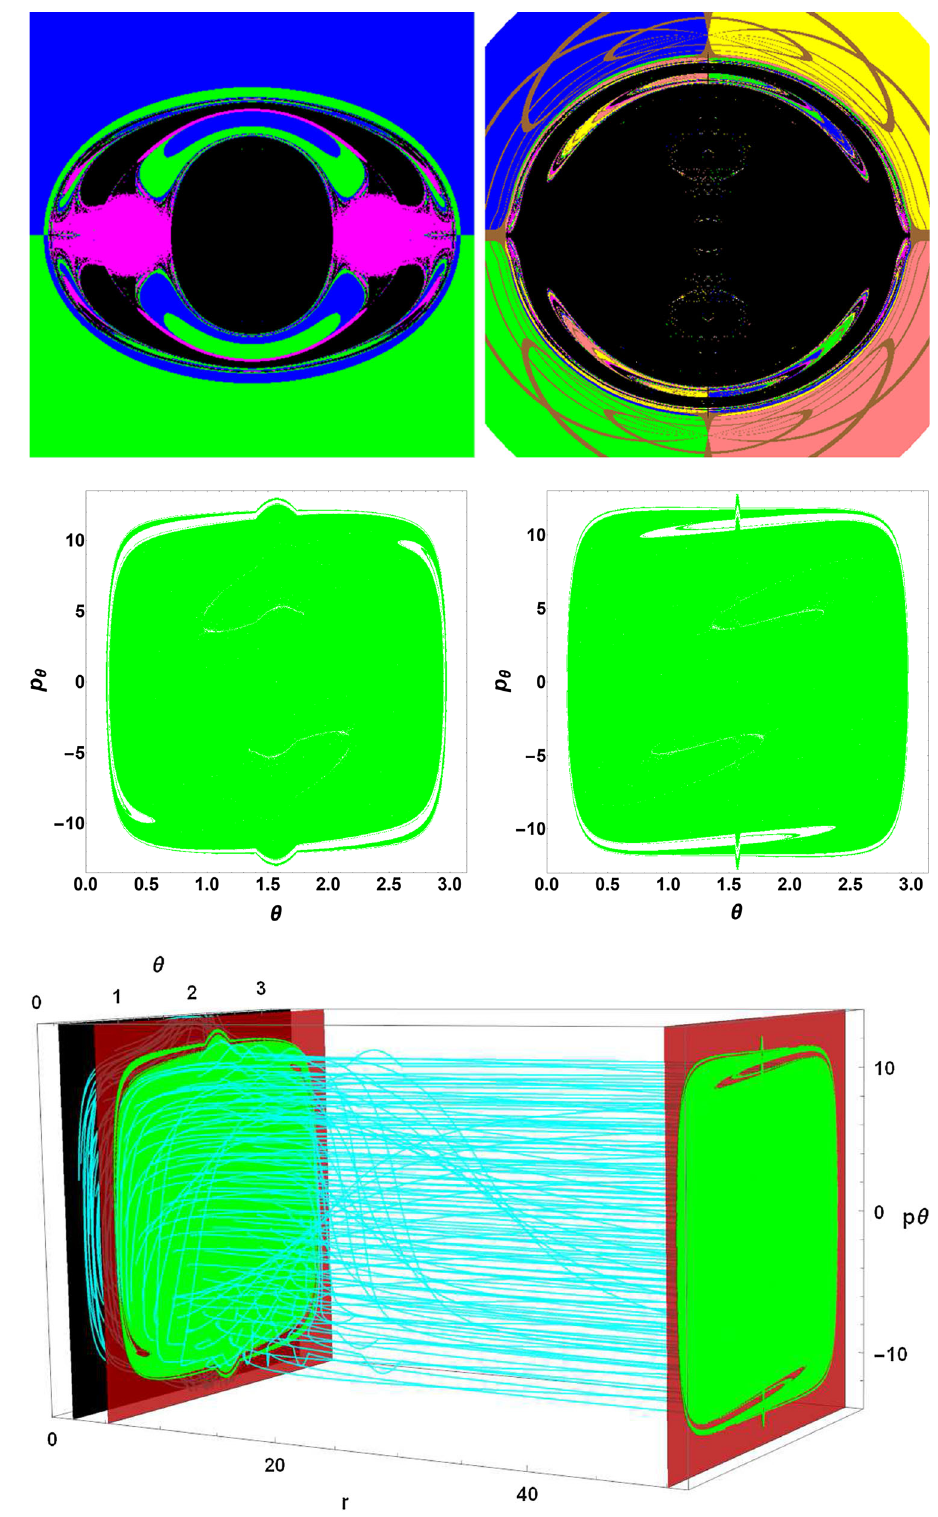
Fig. 6 Comparison between basins of attraction near the photon sphere (in the left panel) and black hole shadow (in the right panel) at observer for a Schwarzschild black hole surrounded by a Bach–Weyl ring with M = 1 . 5 M and Weyl